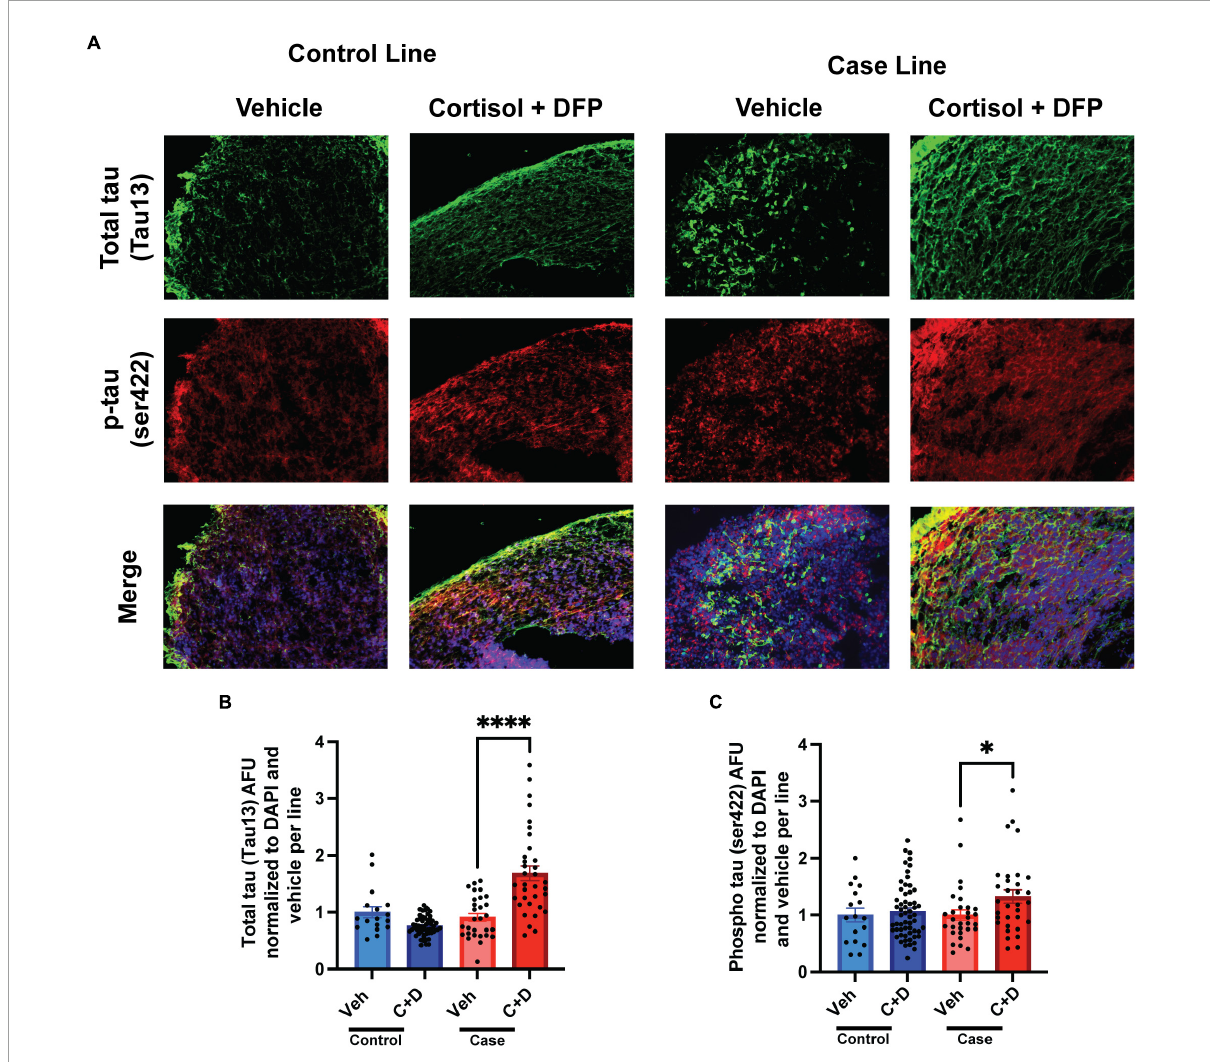
FIGURE2 Gulf War (GW) toxicant regimen produces tau pathology in forebrain cerebral organoids. (A) Representative immunofluorescence images from one control line and one case line exposed to 2 µ M cortisol plus 200 nM DFP show staining for total tau (green) and phosphorylated tau (red) and 4, 6-diamino-2-phenylindol (DAPI) (blue). (B,C) . The graphs show mean arbitrary fluorescence units (AFU) ± SEM normalized to DAPI per line. Total tau increased in the case line by 77.36% (0.7736 ± 0.1412); ps422 increased in the case line only by 32.5% (0.3250 ± 0.1164). ∗ p < 0.05, ∗∗∗∗ p <